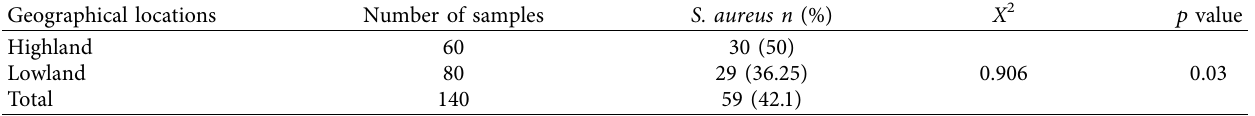
Table 3: Prevalence of bacterial isolates in the study area’s raw cow milk samples.